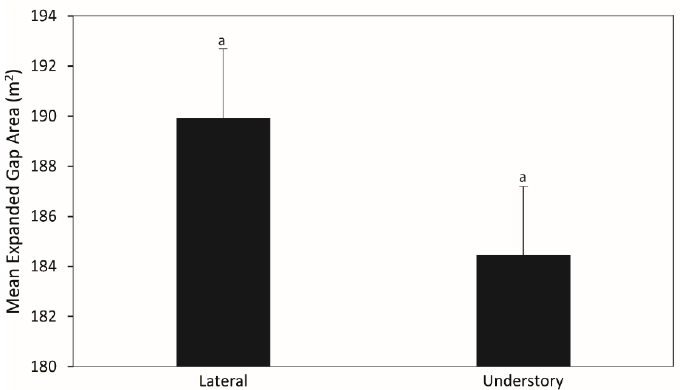
Figure 4. Mean expanded gap area for canopy gaps projected to close via lateral branch elongation and via understory recruitment in a montane Pinus palustris woodland. Different letters indicate a significant ( p < 0.05) difference between categories.